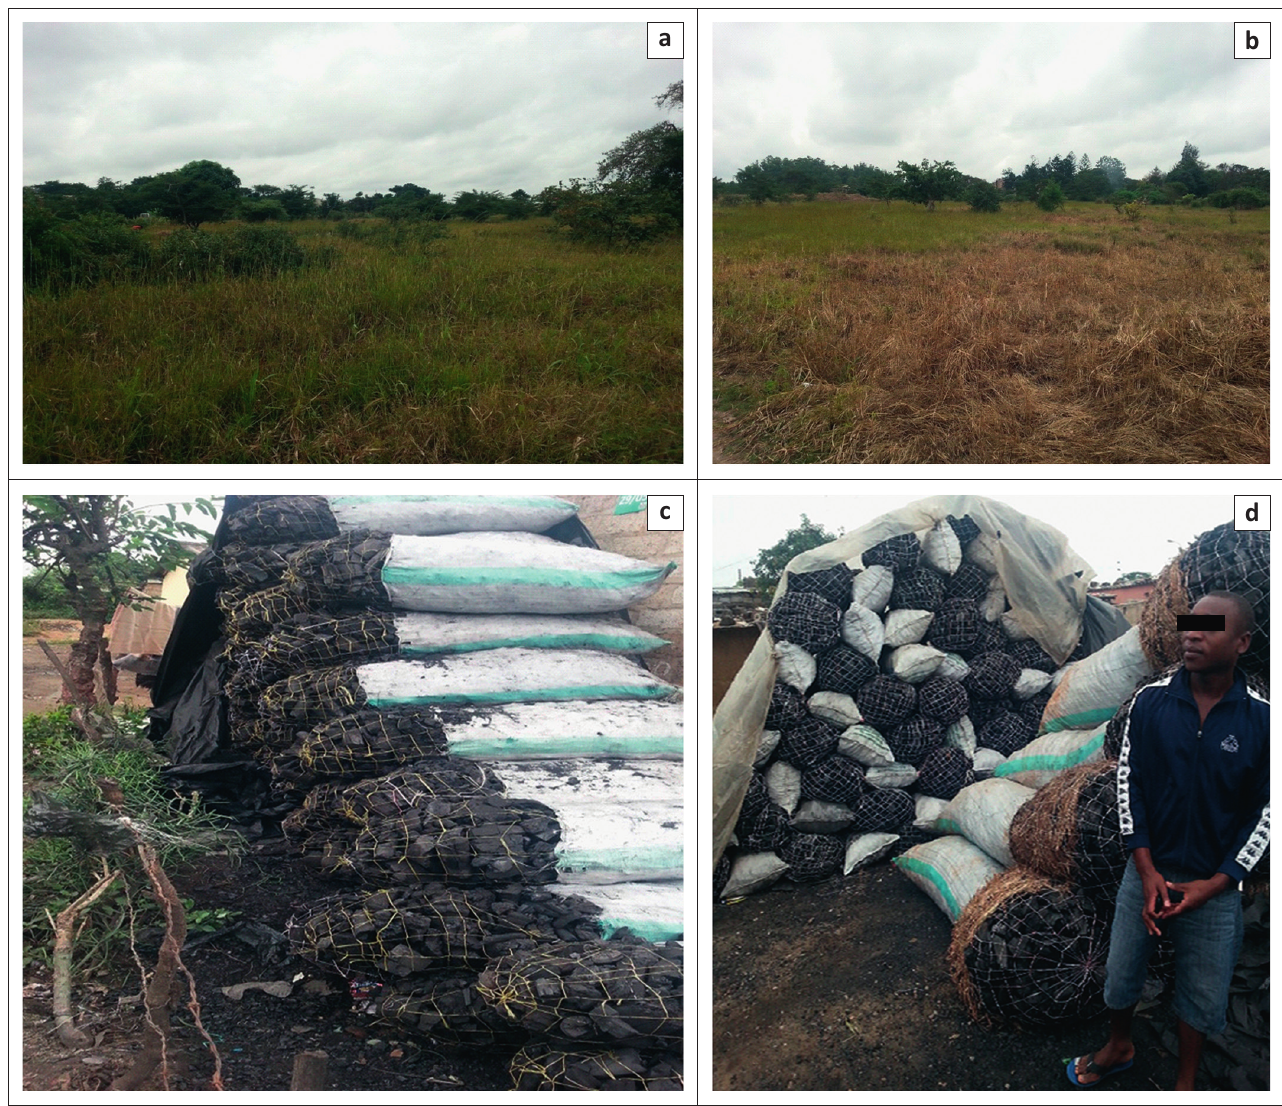
FIGURE 3: Deforestation rate in